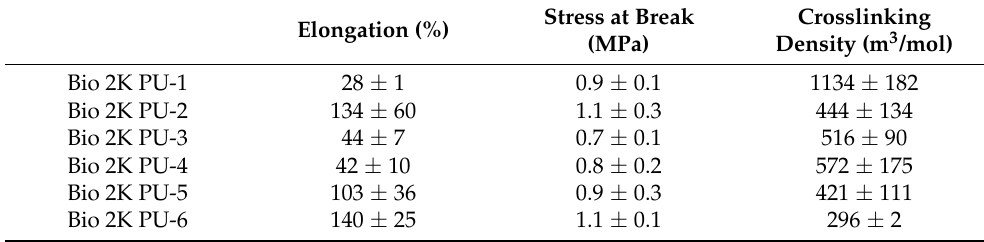
Figure 5. SEM picture of the surface of Bio 2K PU-1. Table 4. Elongation, stress at break and crosslinking density of the different bio-based 2K PU coatings. The reported elongation and stress at break values are the averages of four measurements. The crosslinking densities are the average of 3